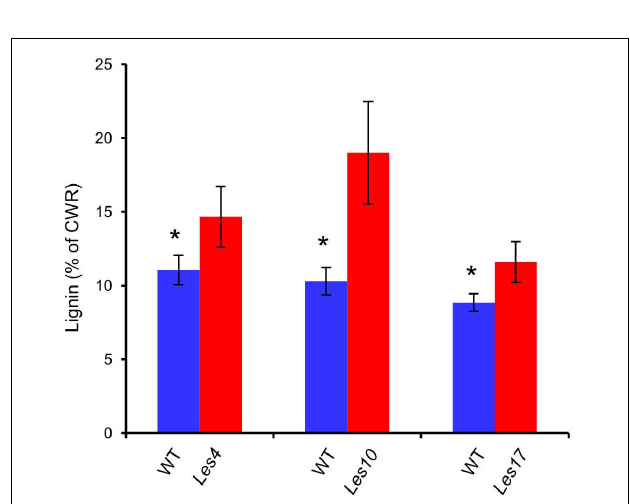
FIGURE 6 | Total lignin content in Les4 , Les10 , and Les17 mutants and their respective wild type. CWR, cell wall residues. Asterisks indicate significant differences compared with wild type (WT) samples (Student’s t -test; * P < 0.05). Error bars represent standard